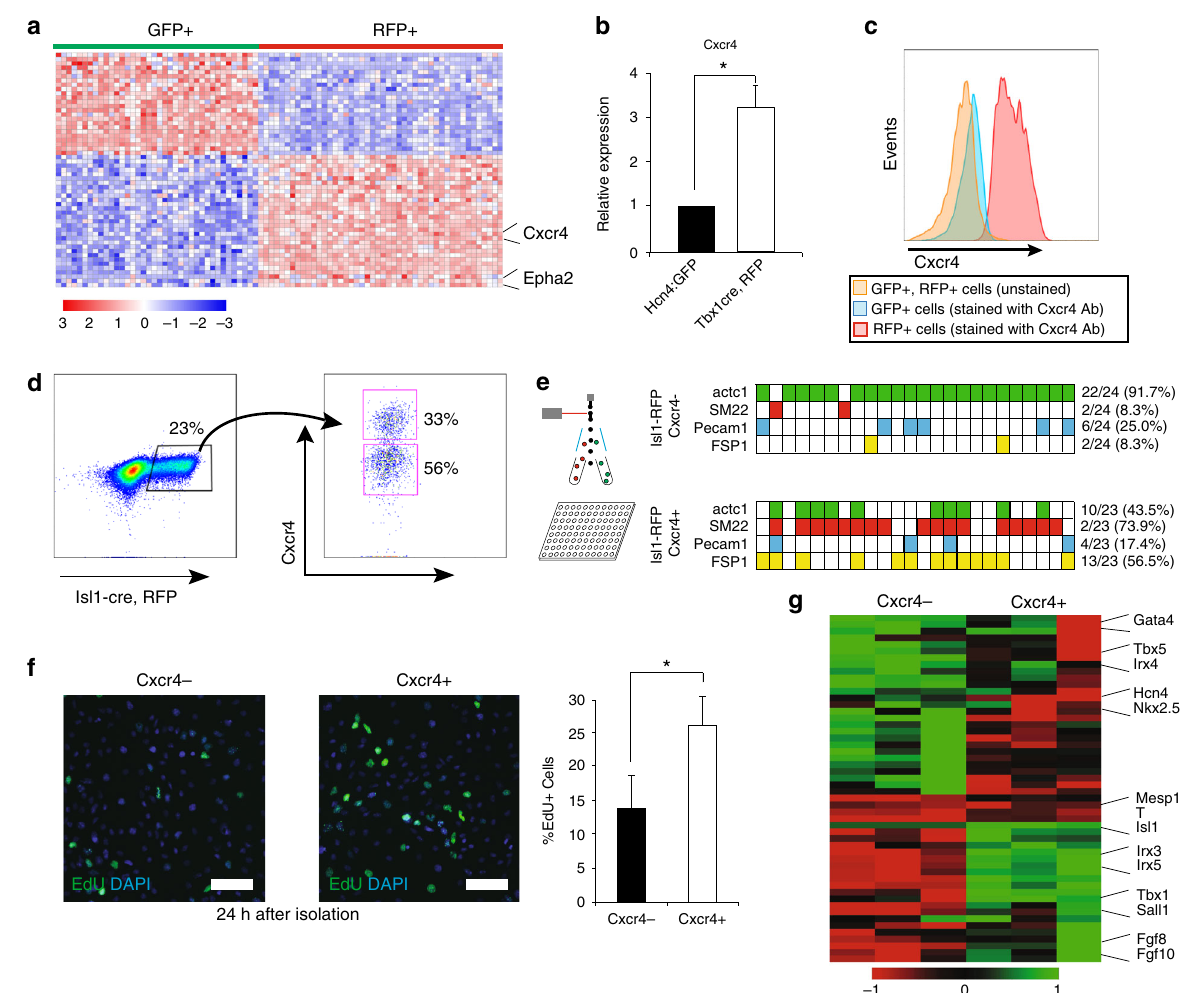
Fig. 4 Cxcr4 marks SHF progenitors in mouse PSC-derived spheroids and in embryos. a RNA-seq analysis of differentially expressed surface receptors between Hcn4-GFP + and Tbx1-cre, RFP + CPCs in vitro. We identi fi ed 240 differentially expressed surface receptors of which the top 55 are shown here (all with Benjamini – Hochberg adjusted p -value < 0.05). b qPCR analysis of Cxcr4 expression in Hcn4-GFP + and Tbx1-cre, RFP + CPCs. Data are mean ± SEM; n = 3; * p < 0.05; p values were determined using a paired Student ’ s t test. c Representative fl ow histograms of Cxcr4 staining of Hcn4-GFP + and Tbx1-cre, RFP + CPCs compared to unstained GFP + /RFP + CPCs. d Representative fl ow cytometric analysis and sorting strategy of Isl1-cre, RFP + CPCs (left) and Cxcr4 − / + CPCs (right). e Clonal cell-fate assay showing qPCR results from 2 × 24 single-cell Cxcr4 − and Cxcr4 + clones, sorted and plated at day 5.5 and analyzed 7 days later. Solid colors represent expression of the gene of interest (Ct value < 30). Green: cTnT, Red: SM22, Blue: Pecam1, Yellow: